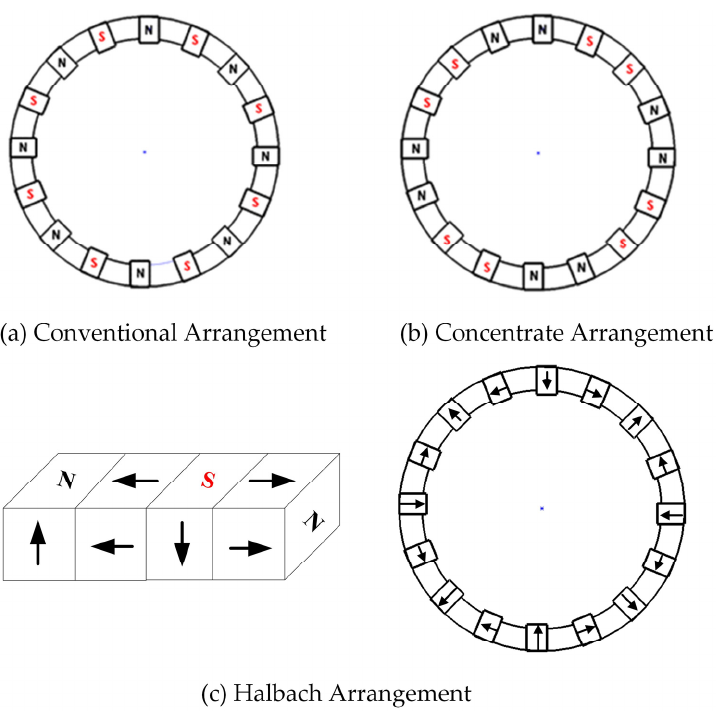
Figure 7. Permanent magnet arrangement. (The direction of the arrow represents the direction of the magnetic